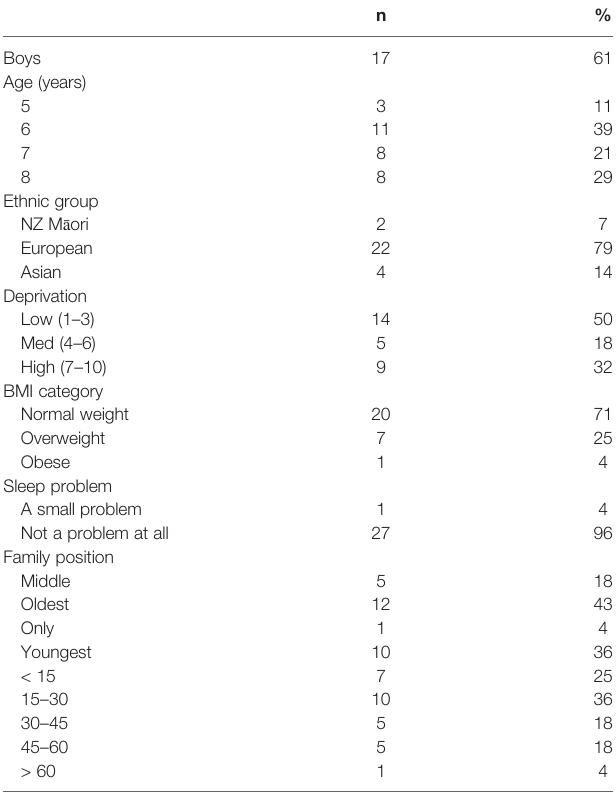
TABLE 1 | Demographic and health characteristics of participants ( n = 28).